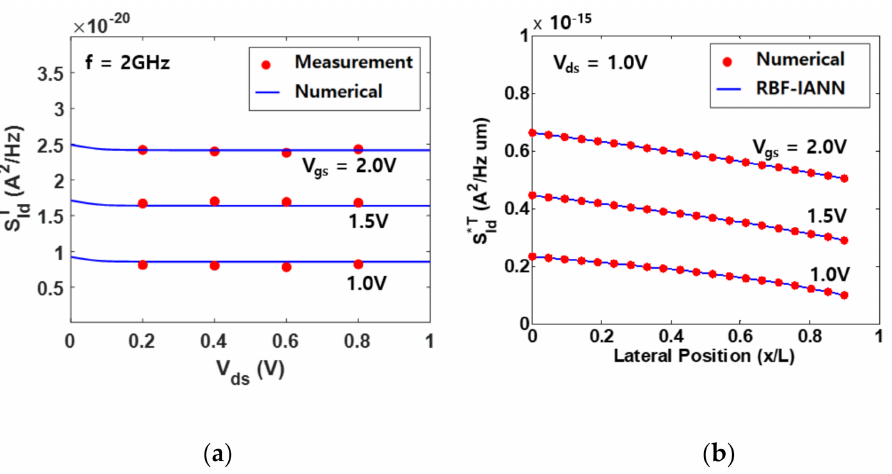
Figure 6. ( a ) Comparison of measured data with numerical results obtained using the analytical model of Equation (7) for the thermal drain current noise and ( b ) the comparison of numerical data with the results obtained using the RBF-IANN model for the integrand of the thermal drain current noise of Equation